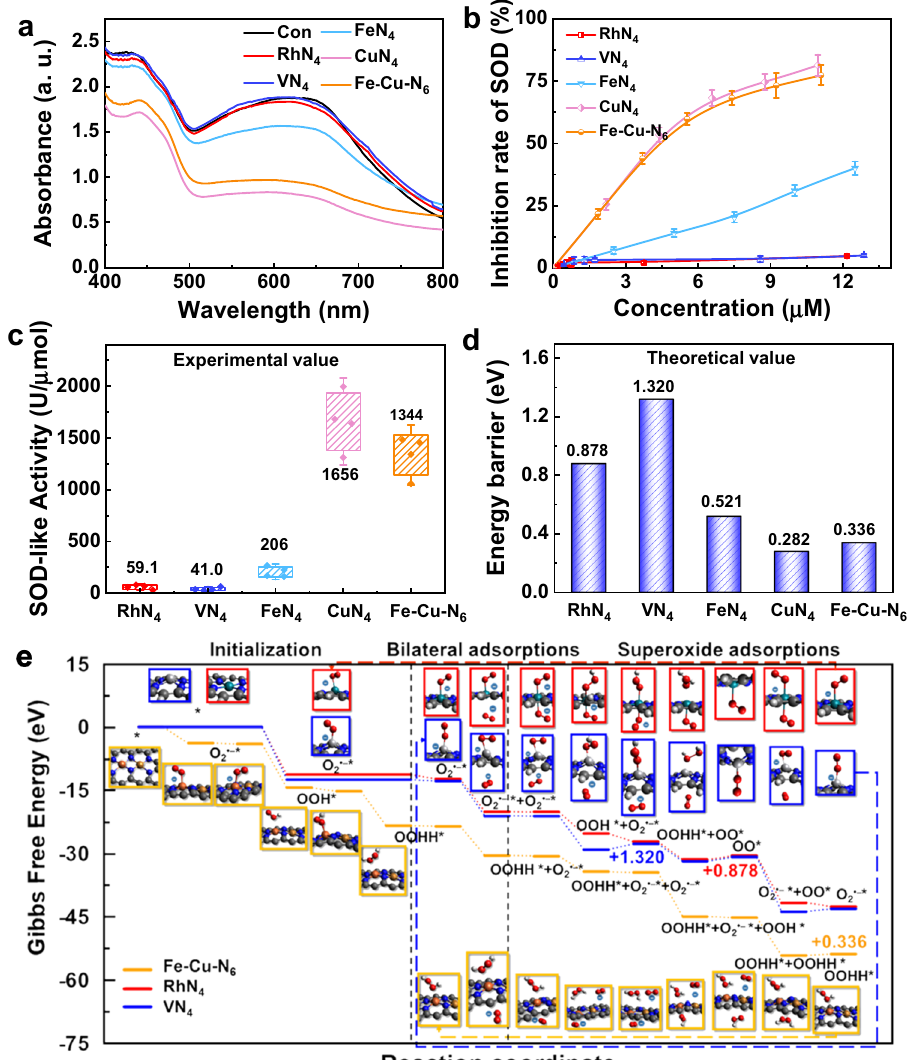
Fig.5|TheSOD-likeactivityofMN x .a SOD-likeactivitieswithandwithoutMN x . ‘ a. u. ’ represents arbitrary units. b Concentration-dependent inhibition rates of MN x calculatedbytheNBTcolorimetricreactionforSOD-likeactivities. c Quanti fi cation of speci fi c SOD-like activities of MN x ( n =4 independent experiments; boxes represent the median and IQR and the upper and lower whiskers extending to the